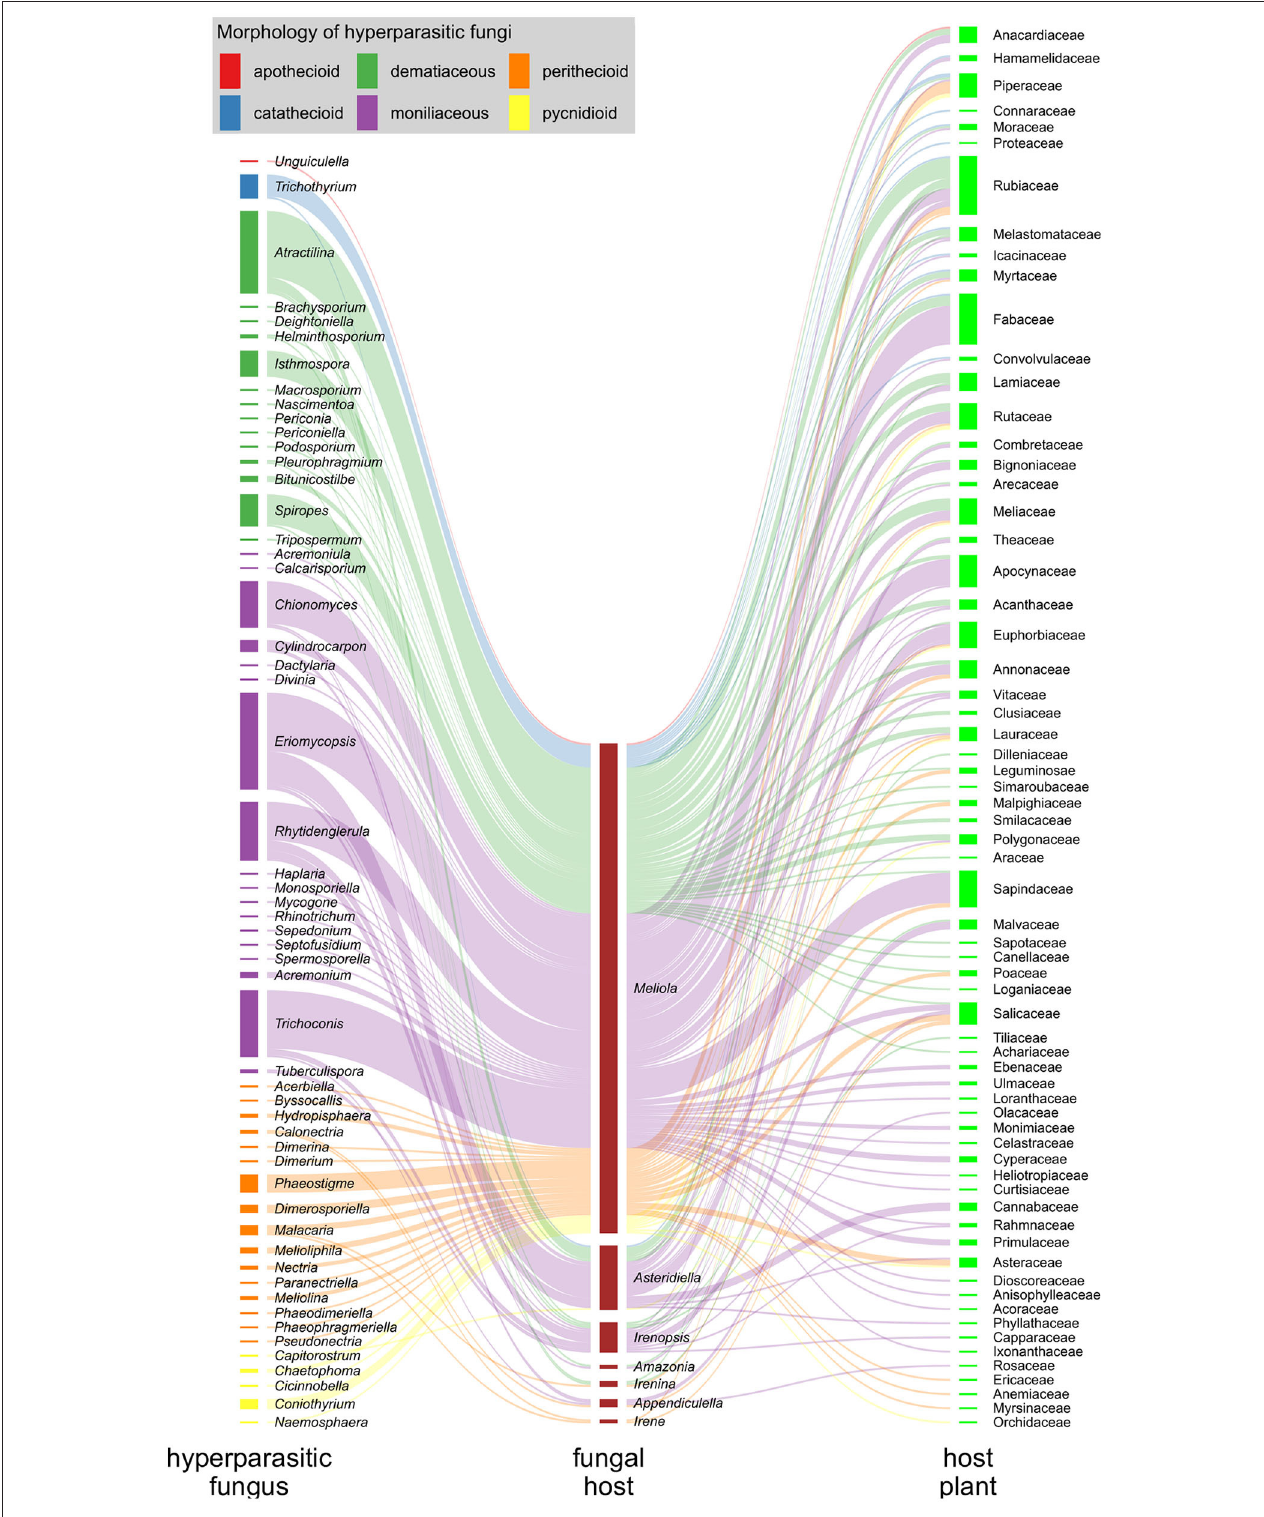
FIGURE 8 | Hyperparasitic fungi-Meliolales-Host plant tritrophic interaction network. Nodes (colored rectangles) represent genera (hyperparasitic fungi, host fungus) or families (host plants), and links (lines) represent species interactions. The width of the nodes and links corresponds to the frequency of records of species interactions. Hyperparasitic fungal species are represented as genera on the left side of the network graph, with colors referring to the morphological group to which they belong; Meliolales species nodes are dark red, and nodes of host plant families are green.